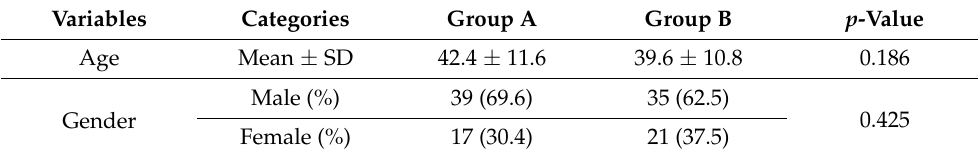
Table 1. Descriptive statistics of demographic data of patients who participated in the current study.